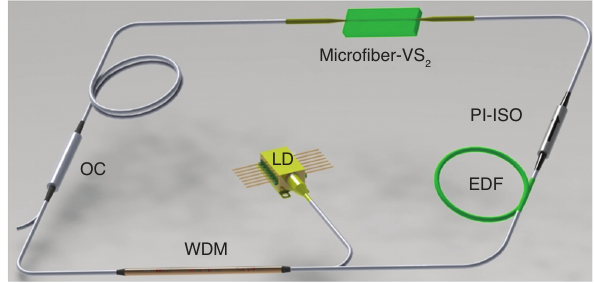
Figure 3: Schematic illustration of the Q-switched EDF laser based on the microfiber-VS 2